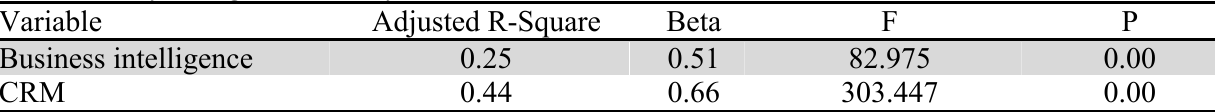
The summary of regression